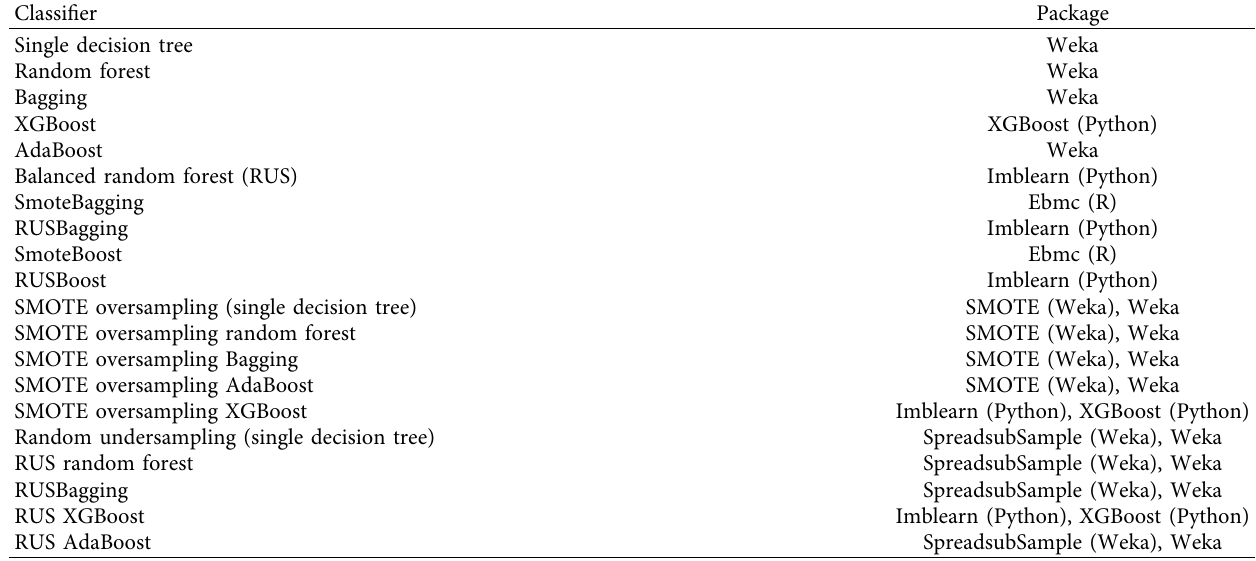
Table 1: Decision tree ensembles and the related packages.